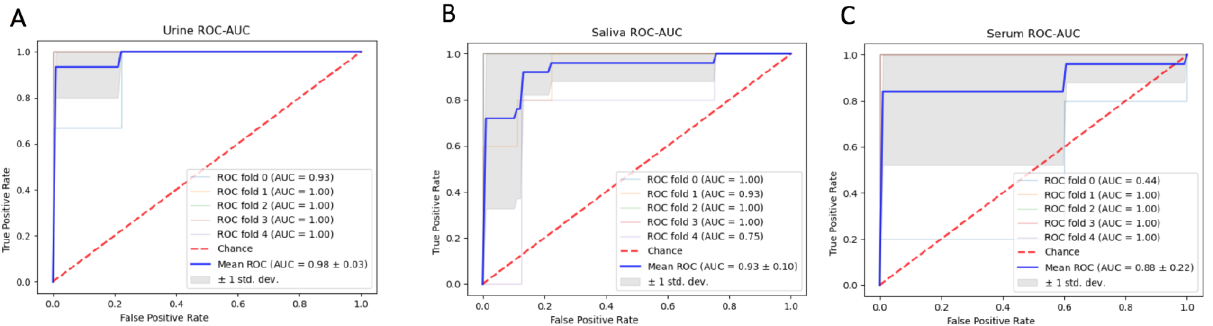
Figure 6. ROC-AUC diagnostic predictors using the selected biomarker candidates for urine ( A ), saliva ( B ) and serum ( C ). The urine model appeared to be the most diagnostic (AUC = 0.98), followed by saliva (AUC = 0.93) and serum (AUC = 0.88). The red dotted line depicts a classifier that has no predictive ability (AUC = 0.5) and the blue solid line depicts the average predictive ability of the diagnostic predictor over five stratified K-fold cross-validations.